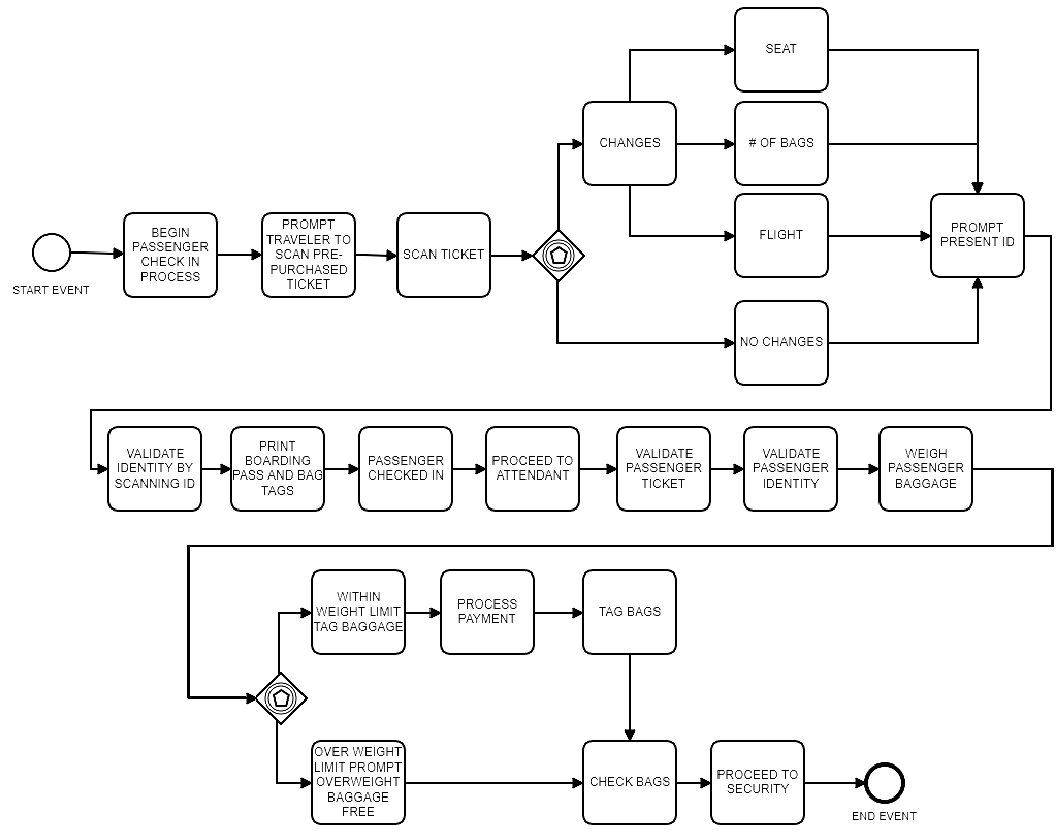
Figure 1. Boarding procedure model.